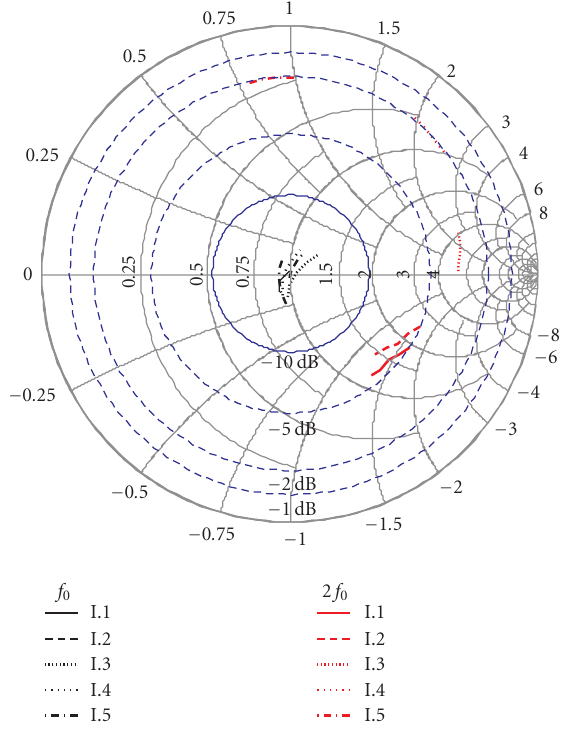
Figure 5: Input impedance over a 200MHz frequency band around f 0 and 2 f 0 for the DRA with a = 3 . 85mm (the geometrical configurations I.1 to I.5 are those listed in Table